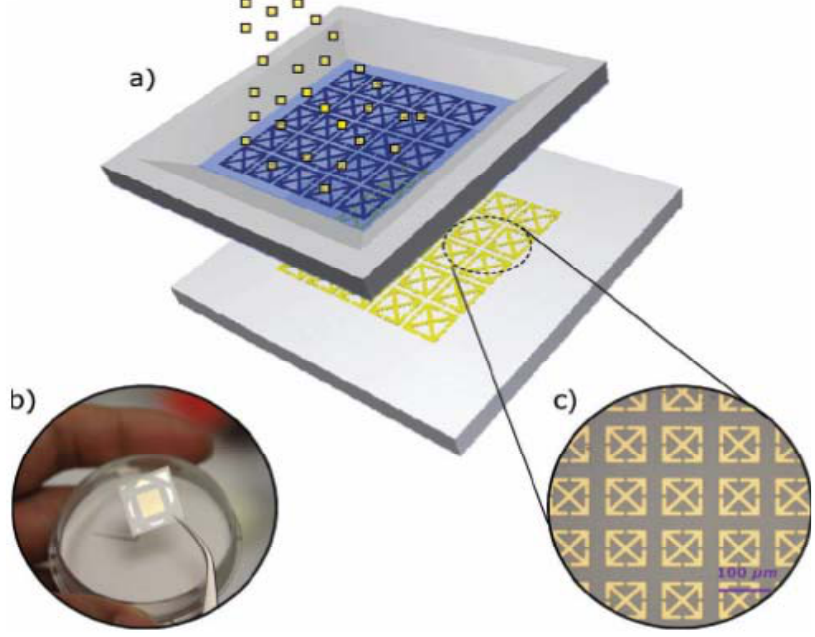
Figure 5. ( a ) Schematic of the micrometer-sized metamaterial resonators sprayed on paper substrates with a predefi ned microstencil; ( b ) Photograph of a paper-based terahertz metamaterial sample; ( c ) Optical microscopy image of one portion of an as-fabricated paper metamaterial sample